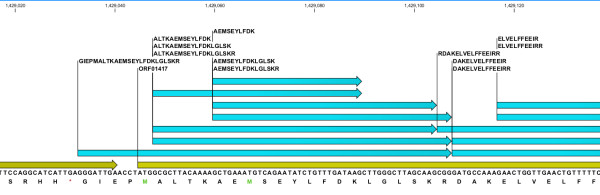
Evidence for potential novel alternative start codon. Multiple peptides (green bars) map to predicted ORF01417 (yellow bar) including one peptide that spans the currently predicted gene start, providing evidence in support of extending the start site. The in-frame * symbol represents the stop codon TGA.